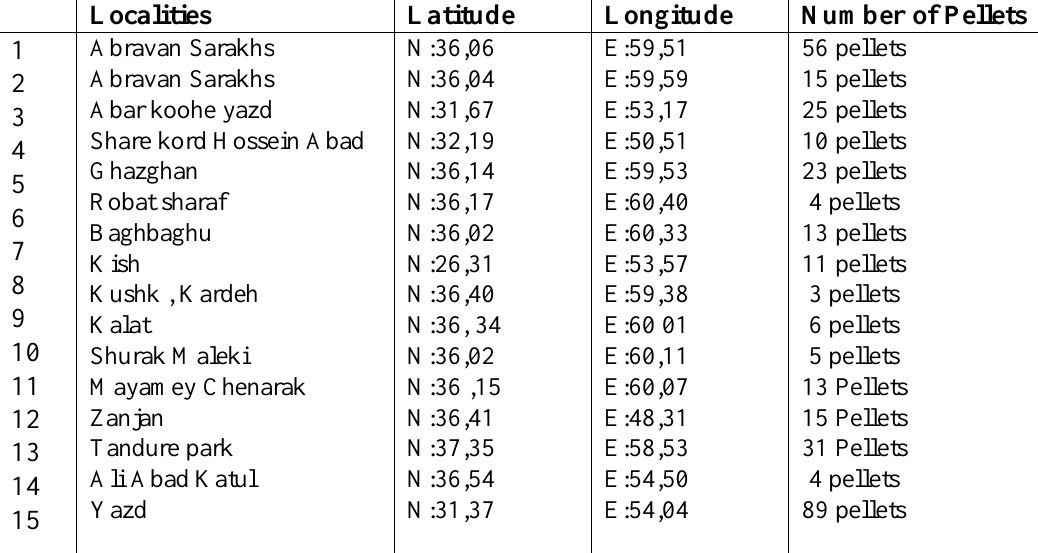
TABLE 1 : The coordinates of sampling localities and the sample size.